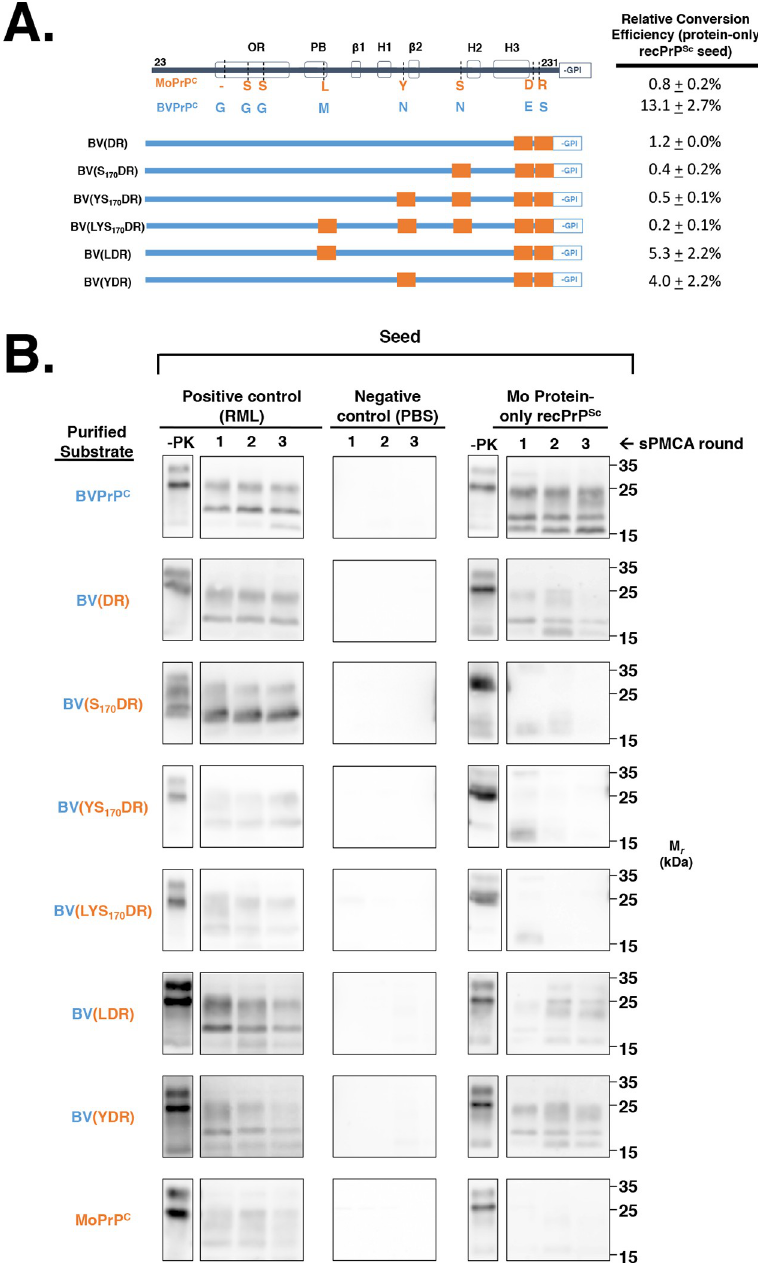
Fig 3. Determining the minimum PrP sequence required for propagation of Mo protein-only recPrP Sc seed. (A) Table summarizing the ability of various BV/Mo PrP C chimeras to propagate Mo protein-only recPrP Sc . All constructs in this series are based on the BV PrP C backbone and become progressively substituted with Mo residues from the C- terminus towards the N-terminus, except for the last two constructs which contain different combinations of 3 Mo substitutions. (B) Western blots of experiments summarized in (A), showing three-round reconstituted sPMCA reactions using partially purified PrP C substrates supplemented with PrP 0/0 BH and seeded with various seeds, as indicated. -PK = samples not subjected to proteinase K digestion; all other samples were proteolyzed. paradigm, BV PrP substitution(s) that are specifically required to propagate Mo protein-only recPrP Sc are identified when the resulting chimera is no longer capable of propagating Mo pro- tein-only recPrP Sc . The results show that substitution of residues 227 and 230 from BV